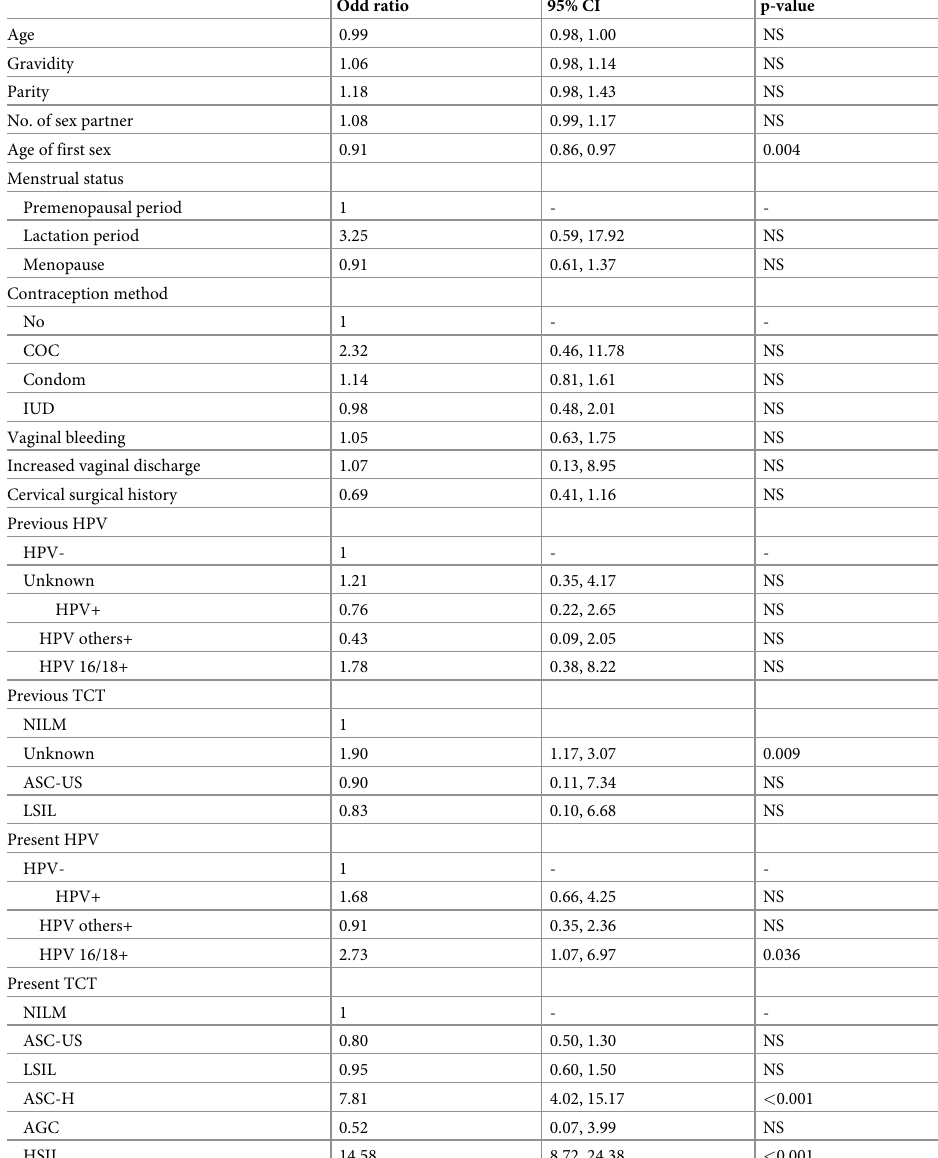
Table 2. Univariate analysis of factor associated with